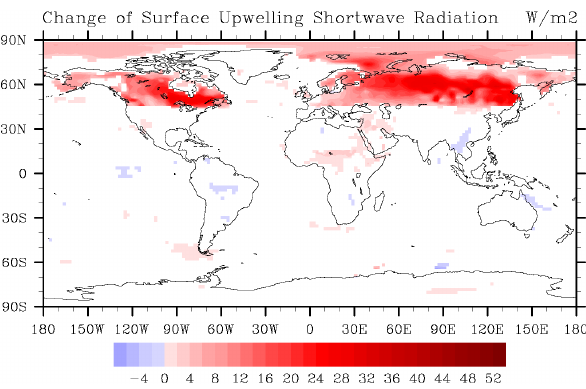
Fig. 11. The same as Fig. 10 but for the change of annual surface upwelling shortwave radiation (Wm 2